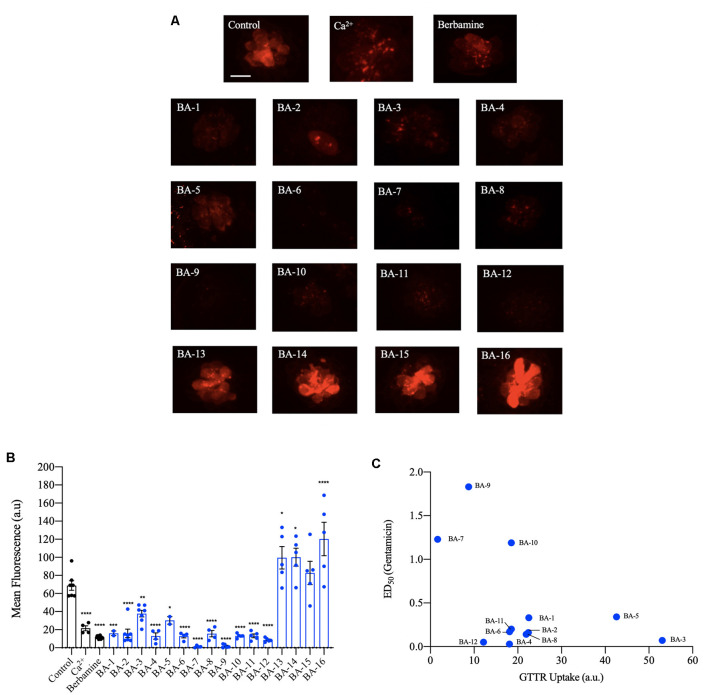
Berbamine analogs reduce aminoglycoside uptake by hair cells. (A) Twelve of the analogs significantly reduced uptake of gentamicin conjugated with Texas Red (GTTR), as did berbamine. Zebrafish were pretreated with the optimally protective analog concentration (or with 25 μM berbamine, Kruger et al., 2016) for 1 h followed by a co-treatment with 50 μM GTTR for 18 min. Dimethylsulfoxide (DMSO) and high calcium are negative and positive controls, respectively. (B) Fluorescence intensity quantification using the OPC of analog. The intensity was measured in arbitrary units and the data were normalized by subtracting the background fluorescence. Data were analyzed via one-way ANOVA, F(17,101) = 38.71, ****p < 0.0001, ***p < 0.001, **p < 0.01, *p < 0.05, asterisks denote significantly different from vehicle controls, N = 4–8 for most compounds, except for N = 2 for compounds BA-1 and BA-5 and N = 15 for berbamine, bars are ± SEM. (C) Linear regression was conducted for analogs that protect hair cells from gentamicin to identify a relationship between analog potency and uptake (y = −0.0203x + 0.9162). The Pearson correlation coefficient of 0.2268 denotes no significant relationship. Berbamine data are replotted from Kruger et al. (2016).